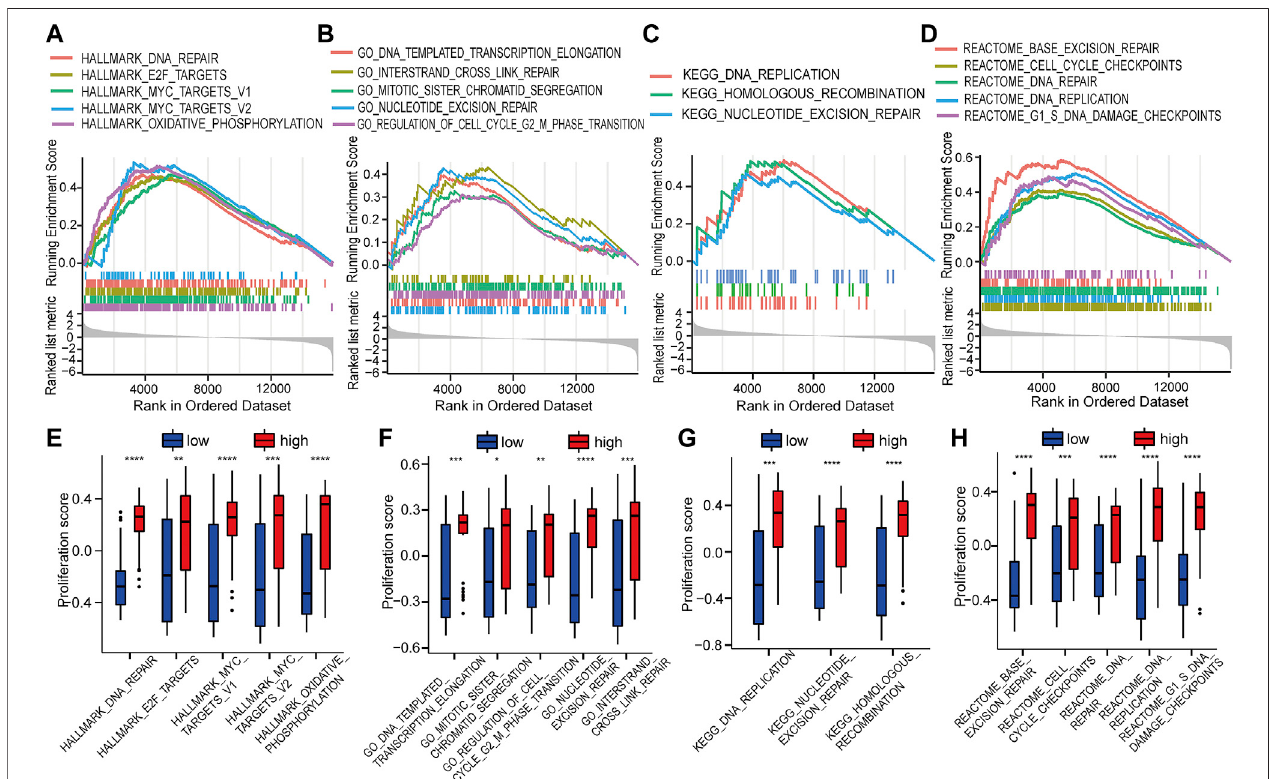
FIGURE5| ThefunctionofHOTAIRM1mainlyinvolves cellproliferationin OSCC further indicatedbyGSEA and GSVA analyses. (A) GSEA identi fi ed the genesets signi fi cantly enriched in Hallmark. (B) GSEA identi fi ed the gene sets signi fi cantly enriched in GO. (C) GSEA identi fi ed the gene sets signi fi cantly enriched in KEGG. (D) GSEA identi fi ed the gene sets signi fi cantly enriched in REACTOME. (E – H) The scores related to cell proliferation assessed in the GSVA in the high-HOTAIRM1 expressiongroupwashigherthaninthelowexpressiongroup,suggestingtheinvolvementofHOTAIRM1inregulatingcellproliferation.* p < 0.05,** p < 0.01,*** p < 0.001, **** p <